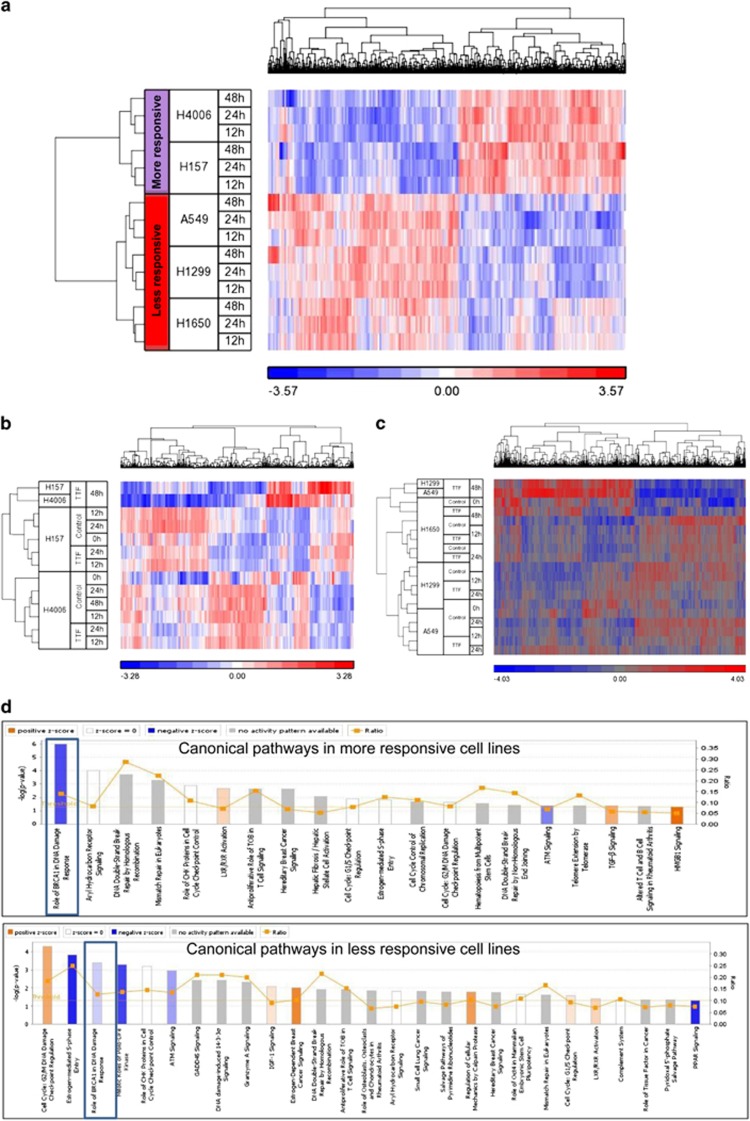
TTFields treatment induces gene expression changes and downregulates BRCA1 DNA damage repair pathway. (a) Supervised clustering using a 1083 gene (FDR<0.01) signature that segregates cell lines by response to TTFields exposure. The heatmap scale is based upon log2 values of normalized gene expression. Clustering analysis of differentially expressed genes after TTFields treatment revealed that (b) 628 genes (FDR<0.05) responded to TTFields in the more responsive cell lines and (c) 1039 genes (FDR<0.05) responded to TTFields in the less responsive cell lines. (d) Identification of differentially regulated canonical pathways for TTFields exposure in the more responsive and the less responsive cell lines. Downregulation of the BRCA1 DNA damage repair pathway is more pronounced in the more responsive cell lines compared to the less responsive cell lines, which is denoted by a decrease in the intensity of blue color reflecting the negative z-scores